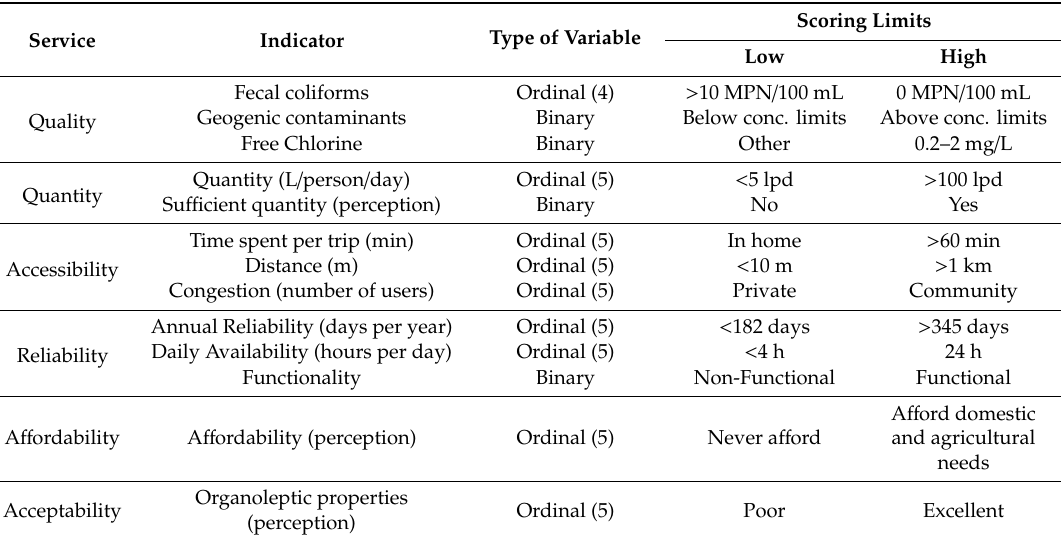
Table 1. Water service level indicators 1 .